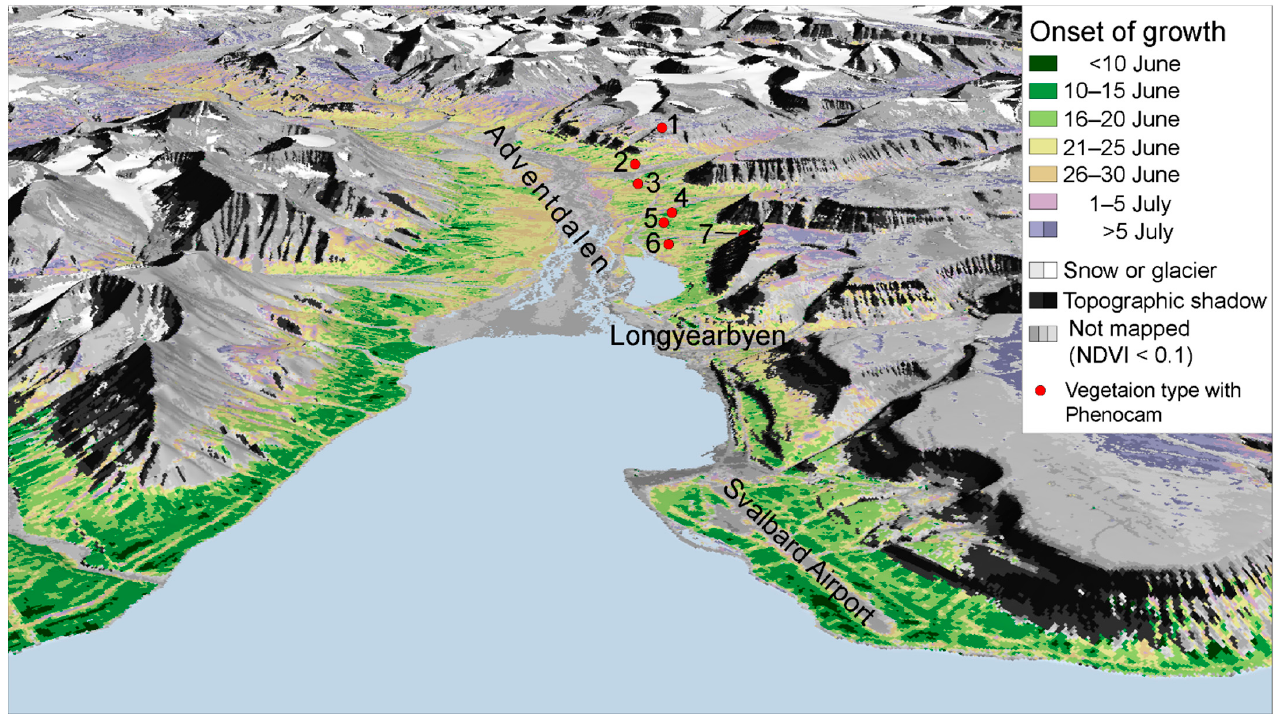
Figure 5. Longyearbyen–Adventdalen valley area seen from northwest towards southeast. Showing mean onset of growth for the 2016 to 2018 period, and the placement of the phenocams.